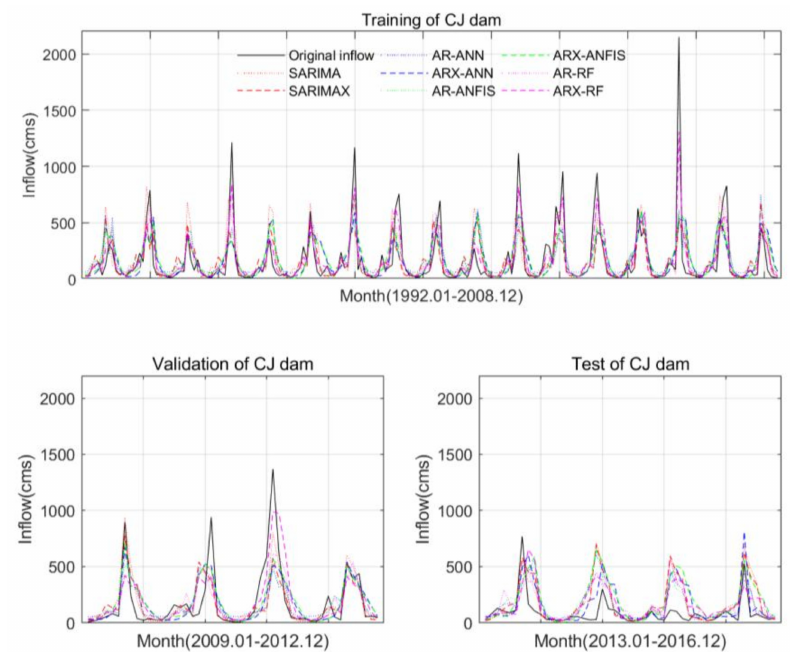
Figure 12. Forecasting results from the eight models in the CJ dam during the training, validation, and test periods (a part of the forecasting results in the training period of the SARIMA and SARIMAX models were illustrated for the validation period).